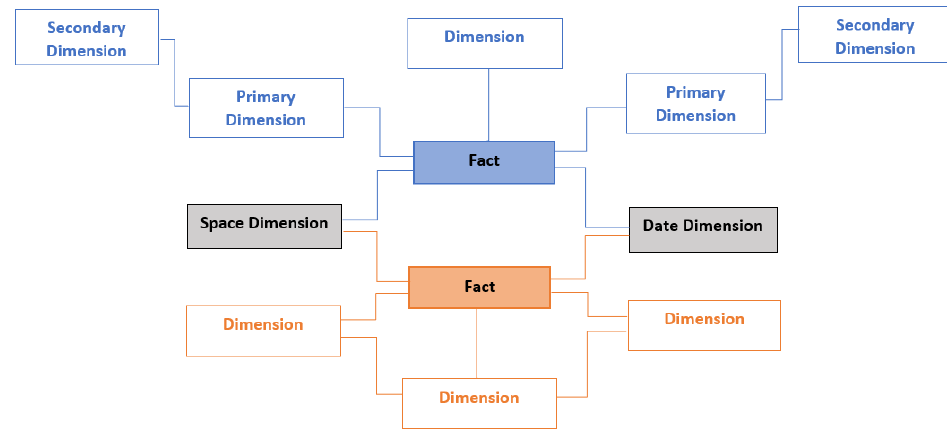
Figure 1. The generic hybrid schema of the DW model.